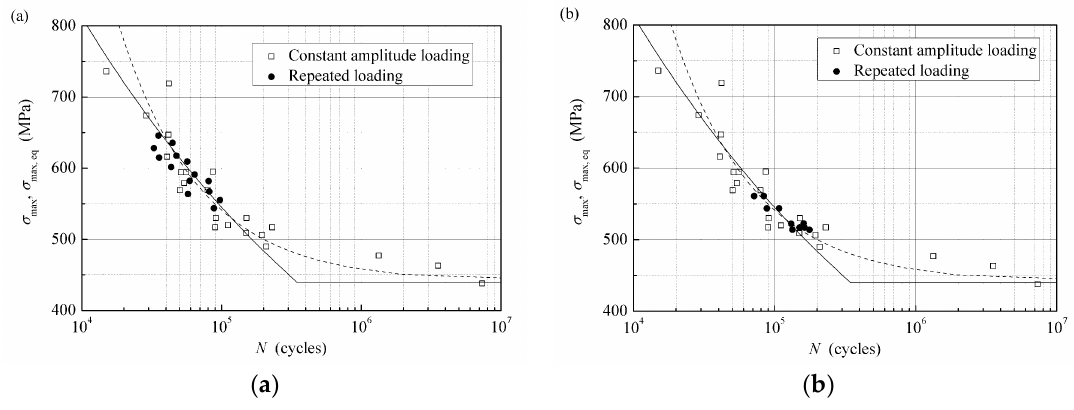
Figure 8. Comparison between the experimental results with ( a ) n L / n H = 1 and ( b ) Δ σ = 59 MPa. Table 4. Test results under the two-level repeated loading with ∆ σ = 59